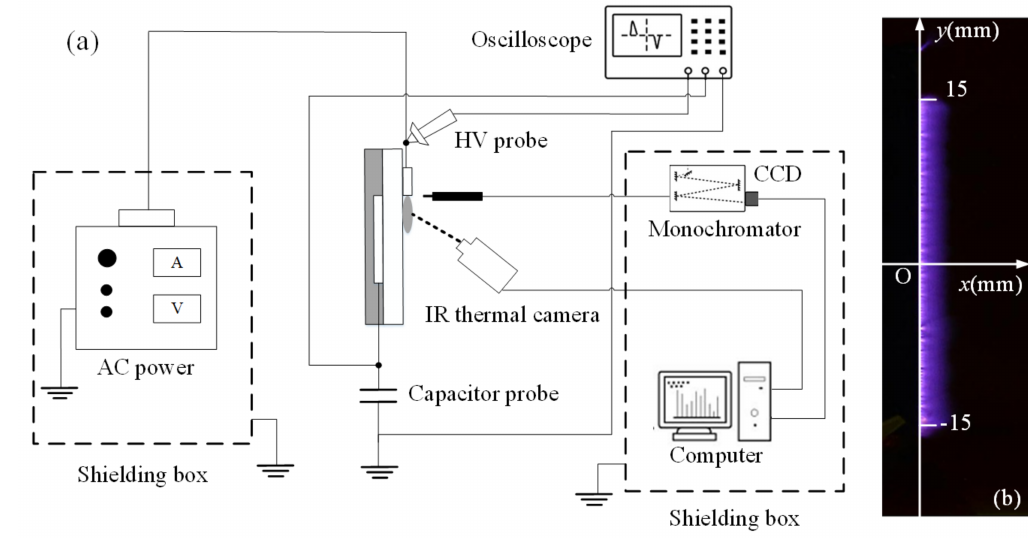
Figure 2. Schematic diagram of the experimental setup ( a ) and top view of discharge plasma ( b ).